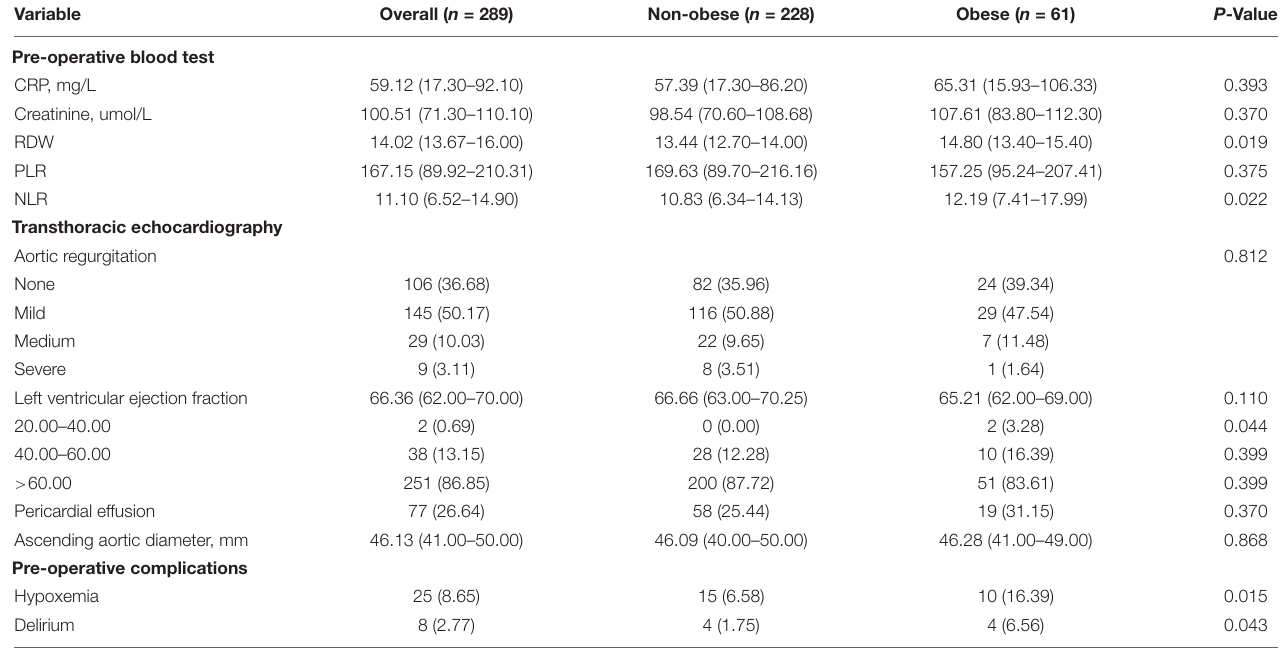
TABLE 2 | Clinical pre-operative